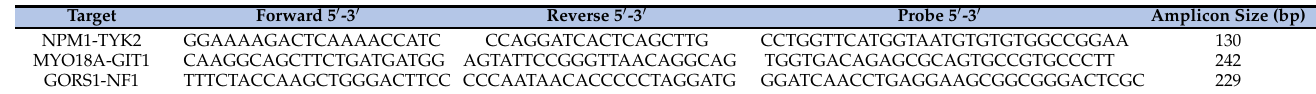
Table 1. RT-PCR primers and probes recognizing fusion